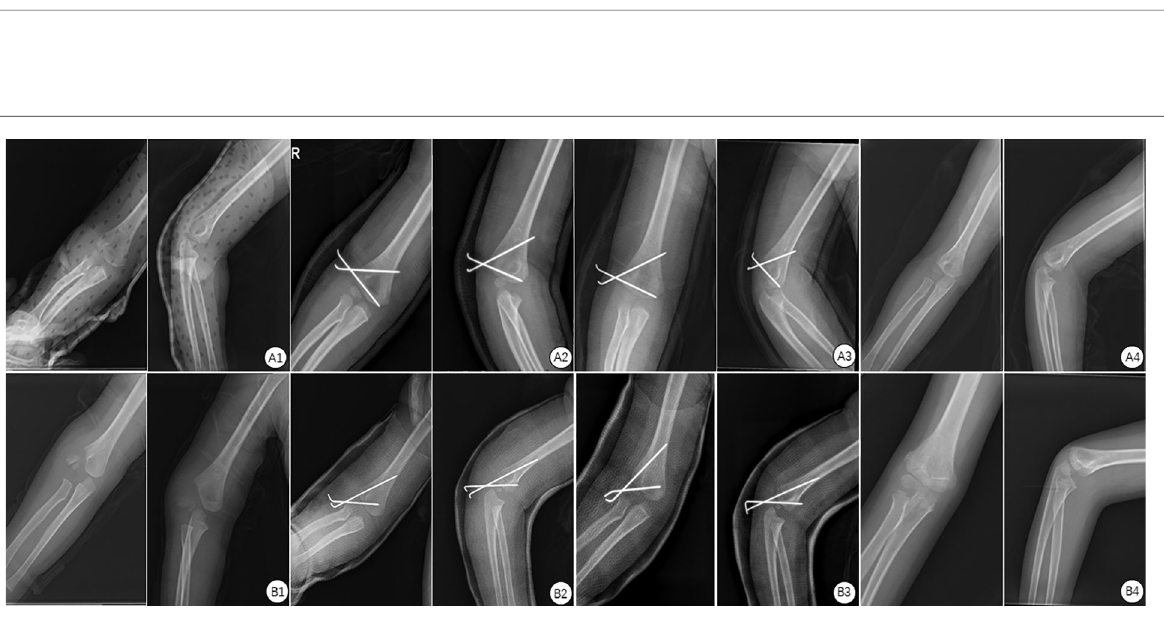
FIGURE 4 ( A1 ) Pre-operative type II frontal and lateral view: fracture of the articular surface, displacement <2mm. ( A2 ) Frontal and lateral view on the fi rst day after operation of type II: the Kirschner wire was stable and the articular surface was continuous. ( A3 ) Frontal and lateral view of type II one month after operation: the Kirschner wire was stable and the callus formed at the fracture end. ( A4 ) Frontal and lateral view two weeks after the plaster removal of type II after operation: the fracture healed well.B1. Pre-operative type III frontal and lateral view: fracture of the articular surface, rotational displacement >2 mm. ( B2 ) Frontal and lateral view on the fi rst day after operation of type III: the Kirschner wire was stable and the articular surface was continuous. ( B3 ) Frontal and lateral view of type III in the second week after operation: the Kirschner wire was stable and the callus formed at the fracture end. ( B4 ) Frontal and lateral view twelve months after the removal of the plaster of type III after operation: the fracture healed